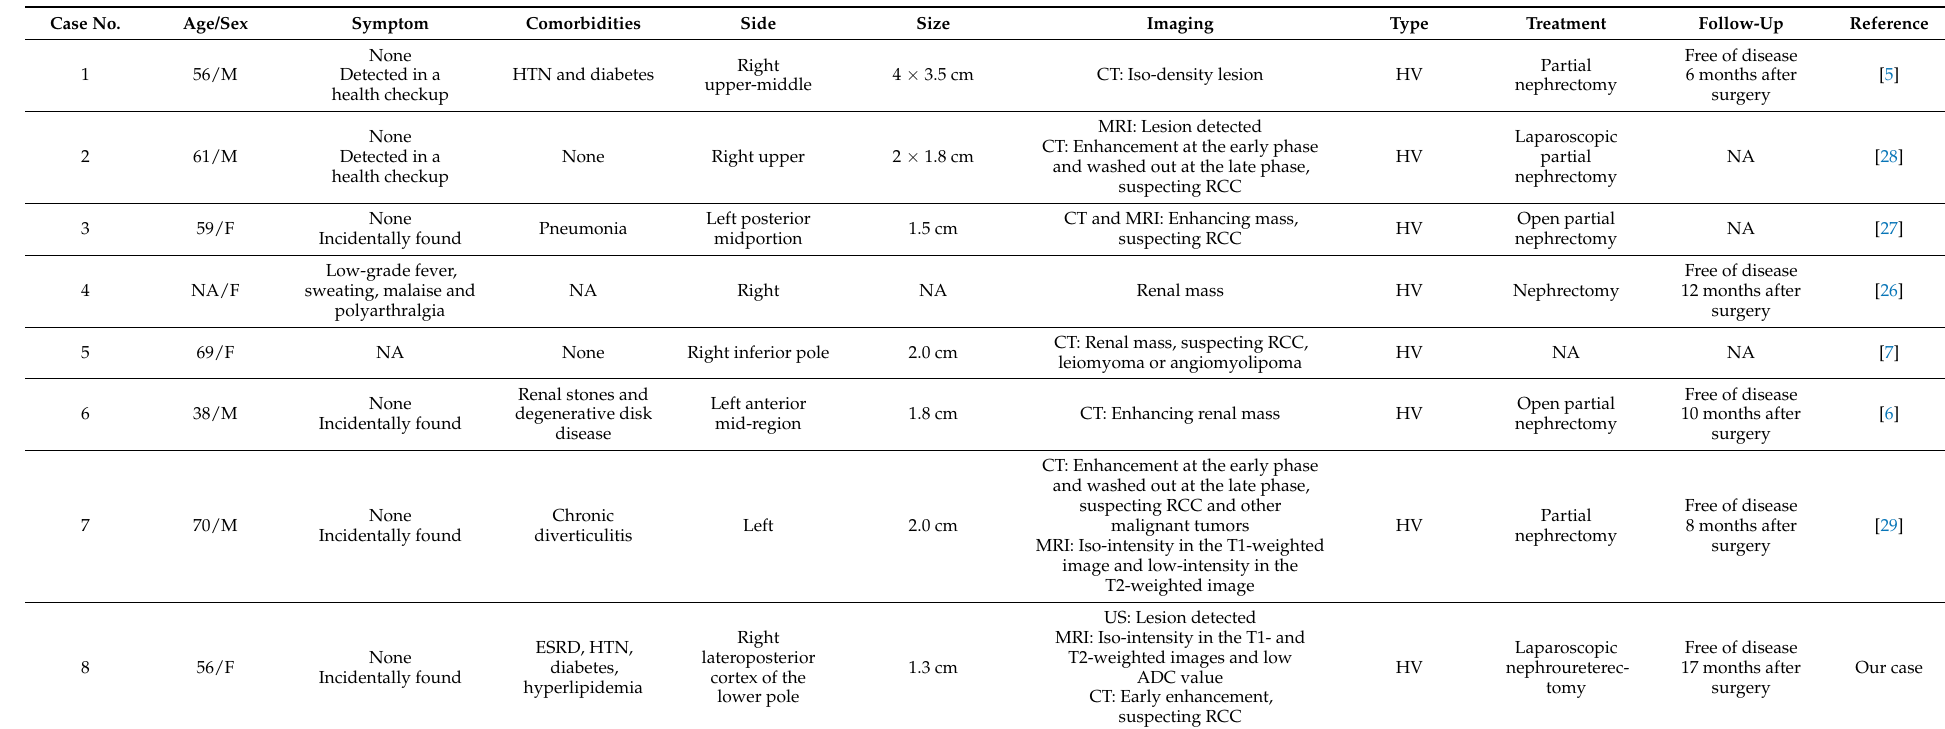
Table 1. Clinical, radiological and pathological features of UCD occurring in renal